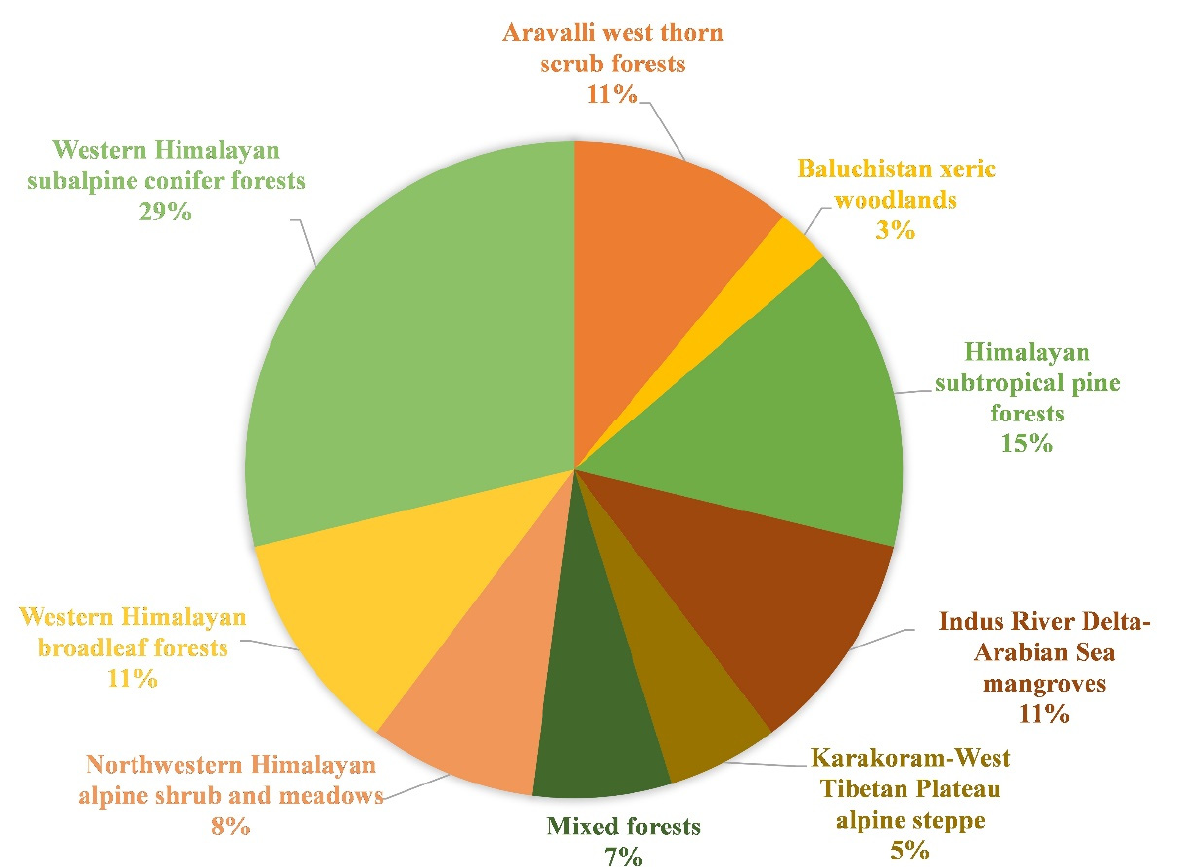
Figure 9. Distribution of studies based on global forest types/ ecoregions.